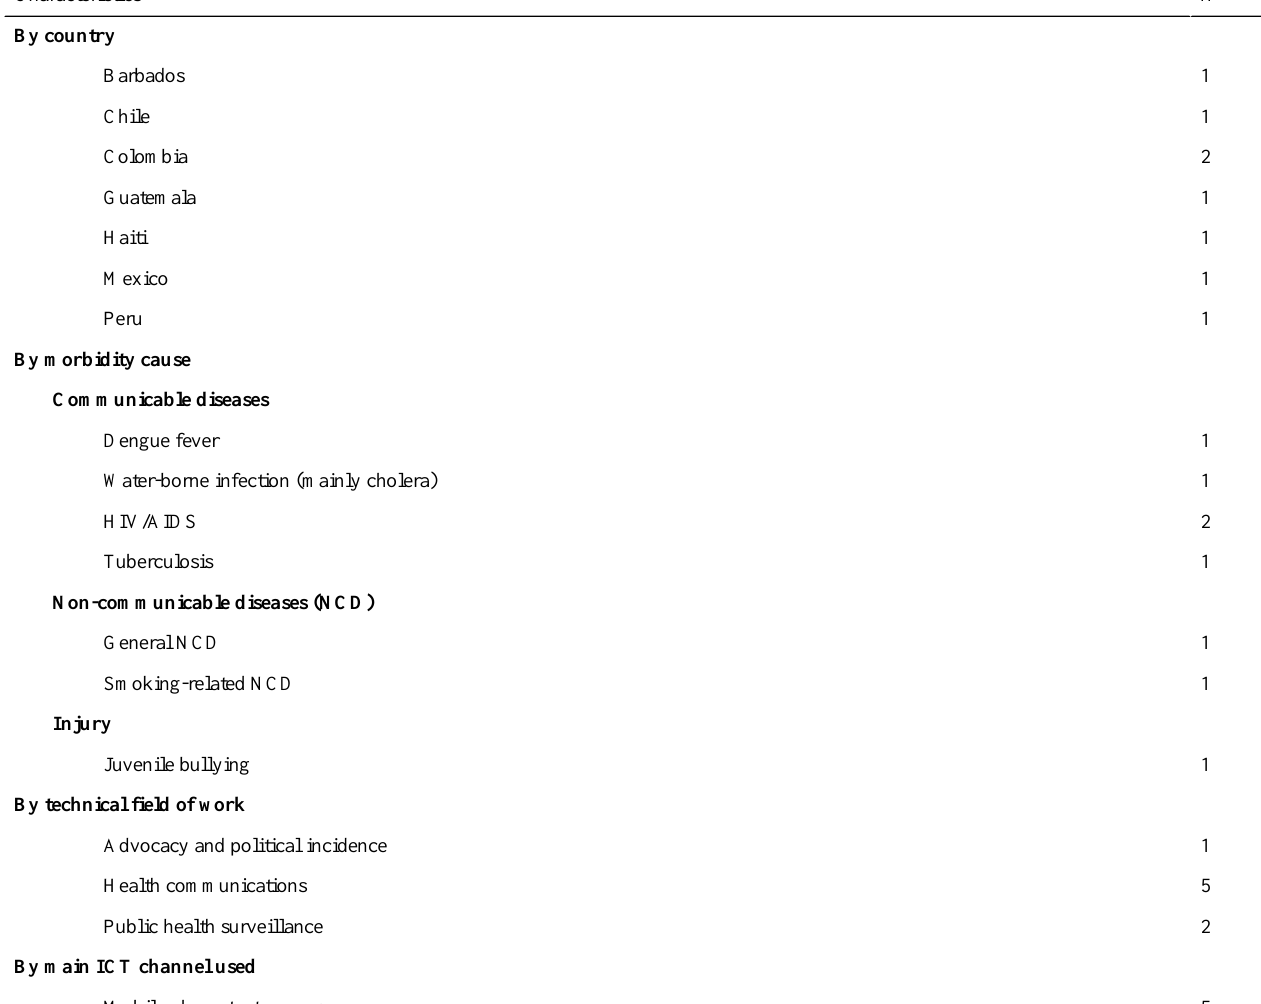
Table 1. Profile of participating projects, by country, fields of work, and funding source